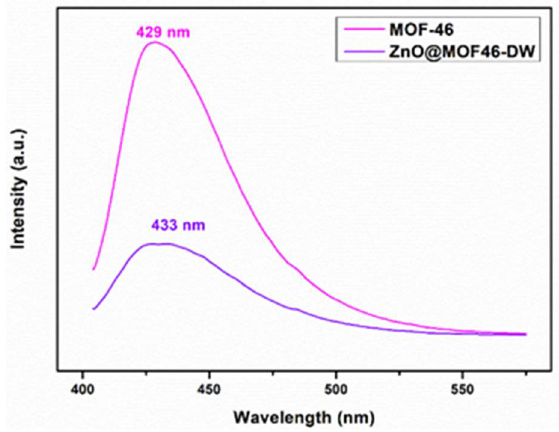
Figure 19. PL spectra of ZnO@MOF-46(Zn)-DW and bare MOF-46(Zn) excited at 385 nm.